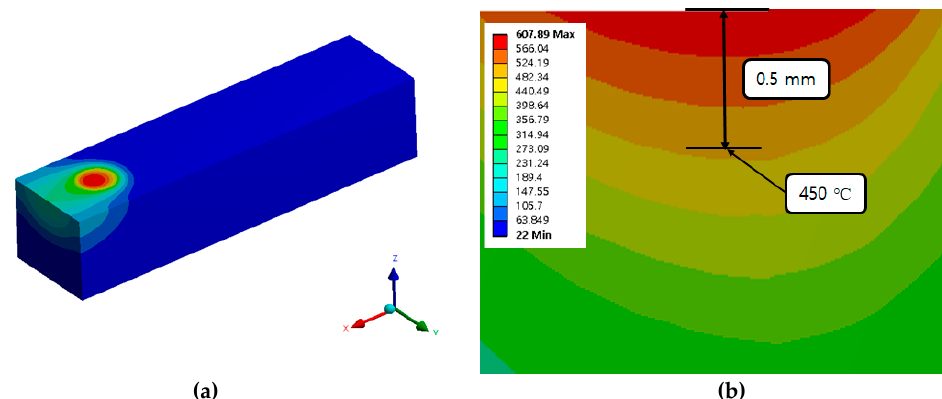
Figure 5. The thermal analysis results of a preheating temperature of 600 °C and a feed rate of 250 mm/min, ( a ) The temperature distribution of workpiece; ( b ) Section view in the x-z plane.